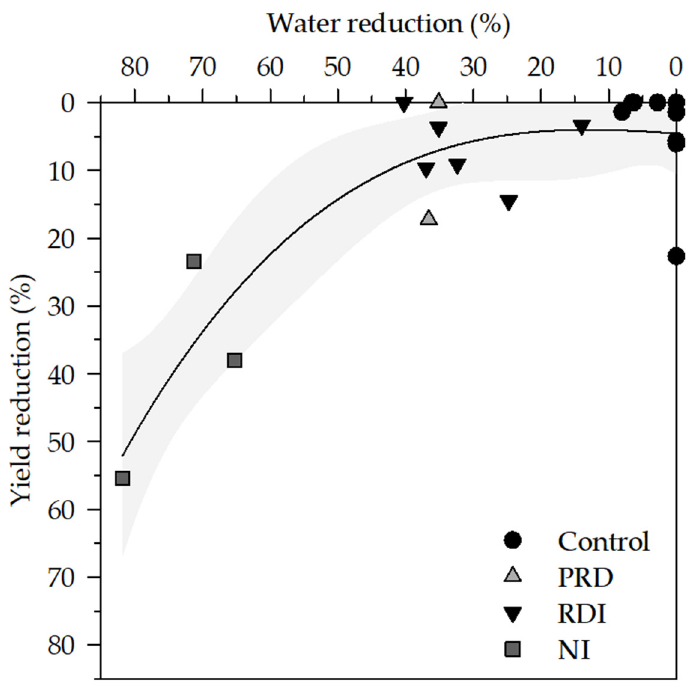
Figure 1. Relationship between irrigation water reduction only during the non-critical period of post-veraison and yield reduction in ‘Crimson Seedless’ vines under different irrigation regimes during several seasons: control (110% of ET c ); RDI—regulated deficit irrigation and PRD—partial root-zone drying at 50% of CTL; and NI—null irrigation, except by rainwater and supplementary irrigation when the Ψ s < − 1.2 MPa. Black line corresponds to regression model 𝑦 = 4.549 − 0.071𝑥 + 0.001𝑥 (cid:2870) + (8.384 (cid:3400) 10 (cid:2879)(cid:2873) )𝑥 (cid:2871) ; R (cid:2870) = 0.754; and grey area to the 95% confidence interval. Each point corresponds to the treatment mean for each season and study site between 2011 and 2017, n = 22.